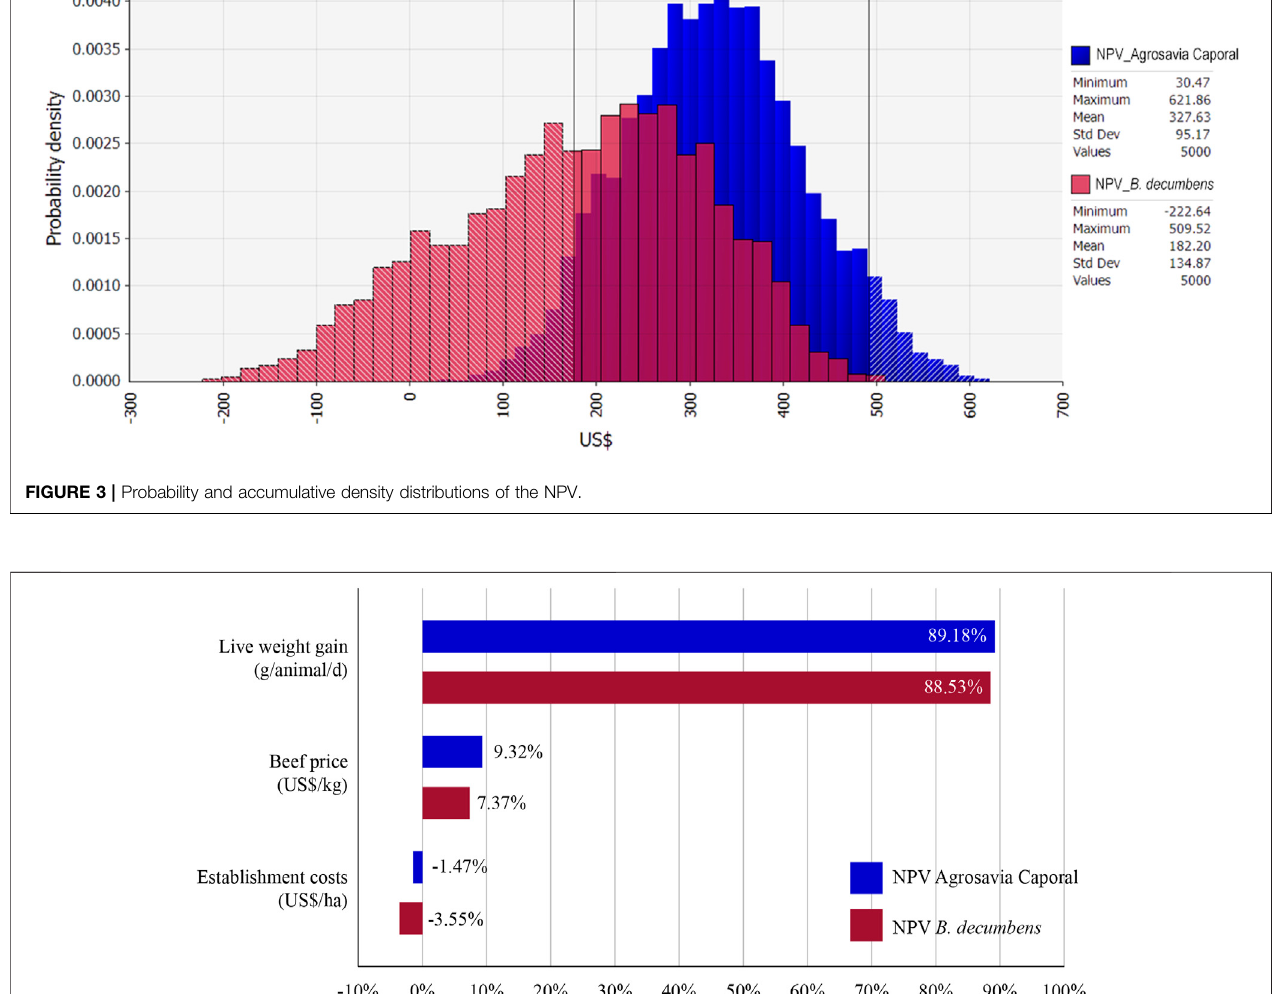
FIGURE 4 | Tornado diagram showing contributions of random input variables to the variance of the